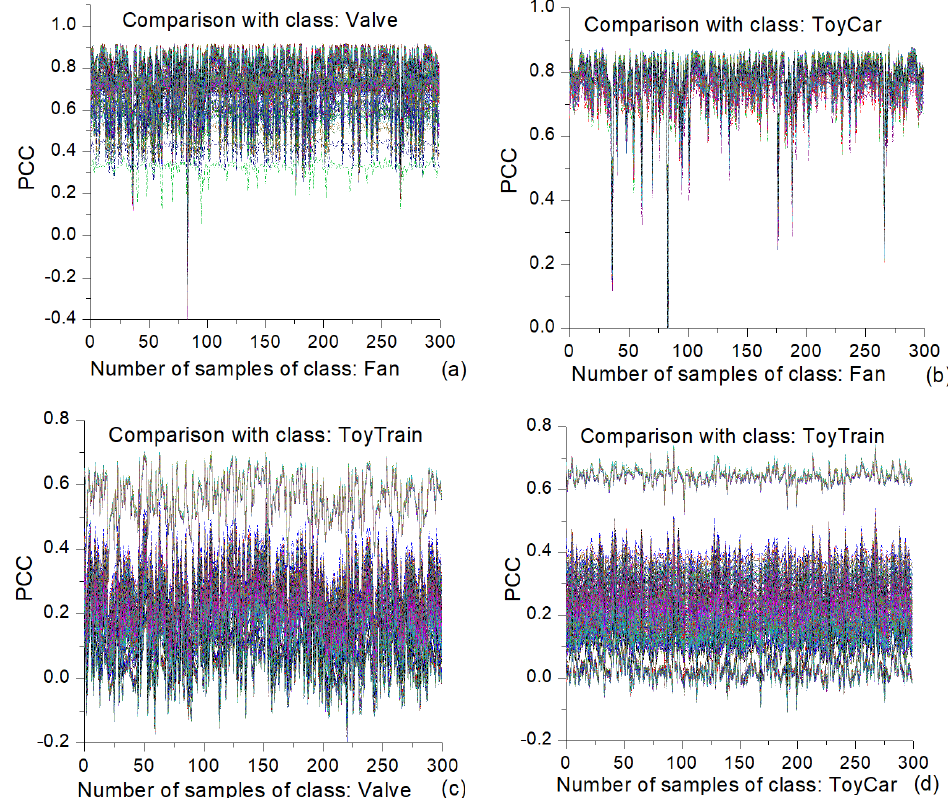
Figure 10. Line plots of interclass PCC similarity values for individual samples from the paired classes in the extracted dataset: ( a ) fan − valve, ( b ) fan − toy-car, ( c ) valve − toy-train, and ( d ) toy-car − toy-train (300 lines in each plot).